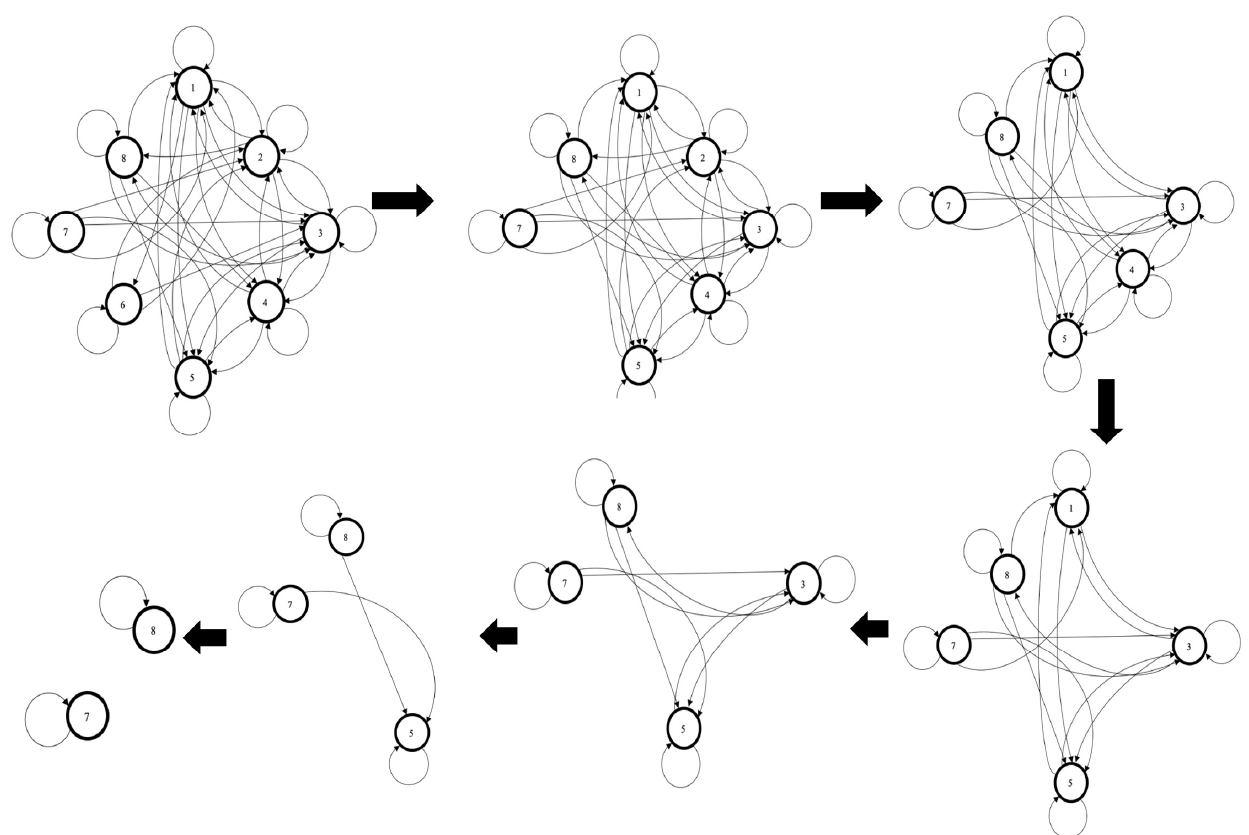
Figure 10. The dynamic of graph of the 8 macro-districts. The dynamicity of the MACS graph is simulated by MACSGA (see Table 3) whereby the lowest value for PFE is determined, hence its respective vertex of MACS is removed. The two surviving vertices that represent the two districts (Mage and Itaguai) of Rio indicated the main sources of the